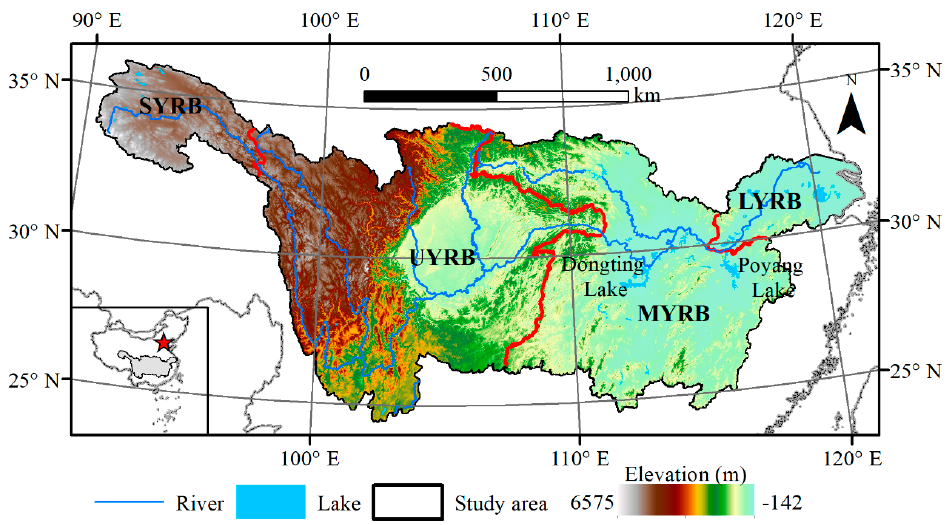
Figure 1. The location of the study area.